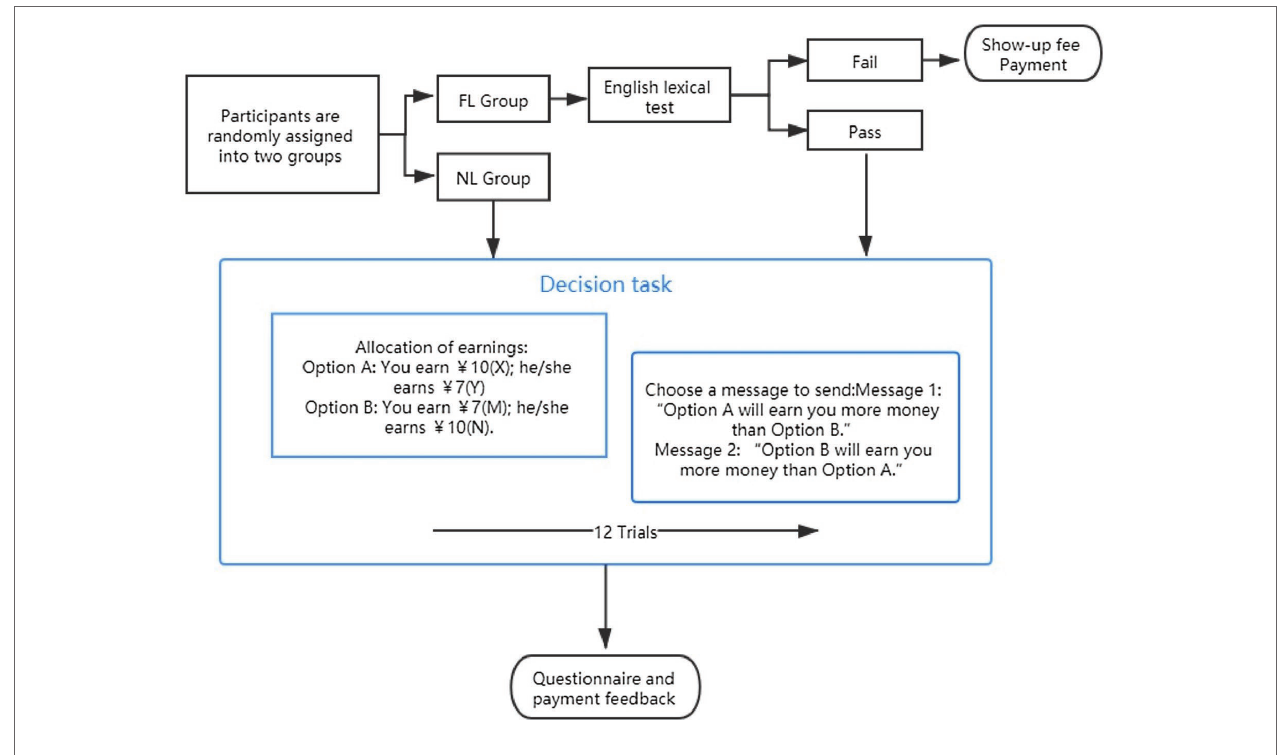
FIGURE 2 | Procedure of the experiment.